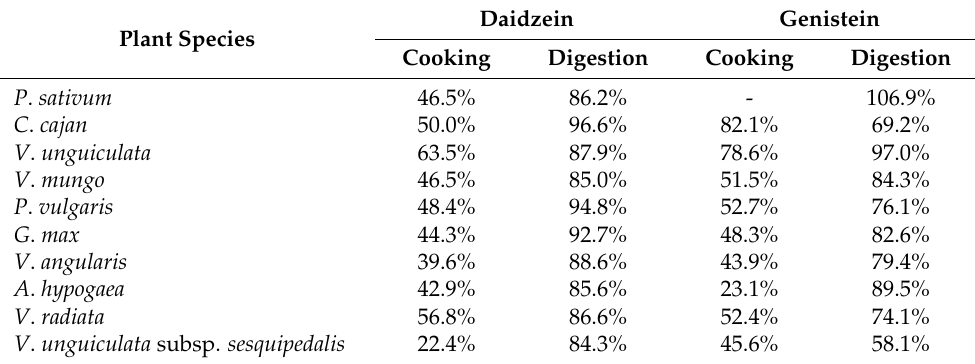
Table 4. Bio-accessibility (in %) of daidzein and genistein after traditional cooking (cooked) and after traditional cooking followed by in vitro gastro-intestinal digestion (Digestion) from beans from ten Fabaceae